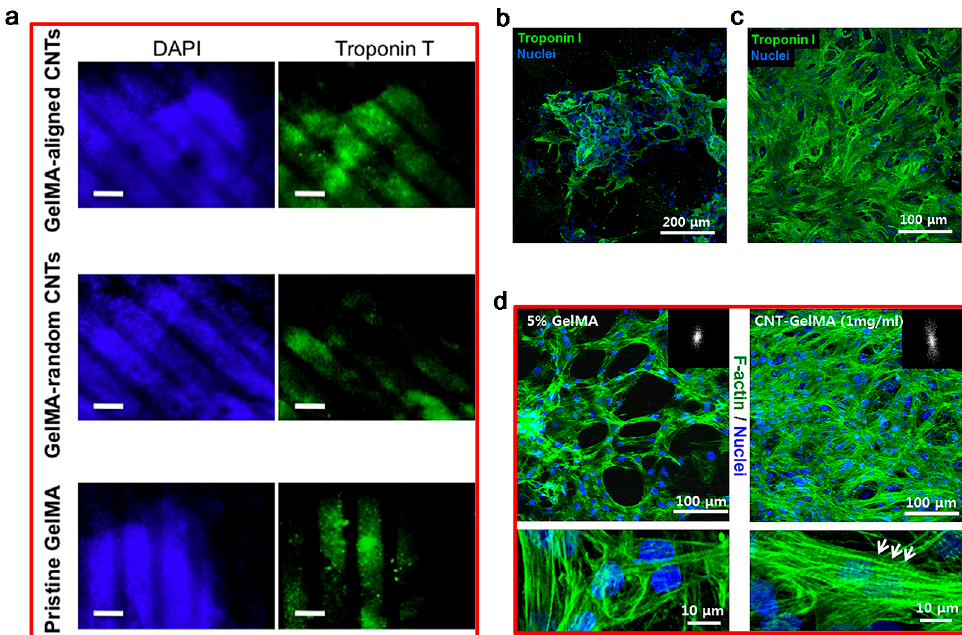
Figure 15. ( a ) Cardiac di ff erentiation analysis by applying DAPI (blue) and Troponin I (green) staining on pure GelMA and CNT–GelMA with embryoid bodies, by Ahadian et al. Low cardiac di ff erentiation is indicated by low expression of Troponin T [185]. (Right) Cardiac cell phenotype examination on the hydrogels by Shin et al. showed more aggregated Troponin I presence on ( b ) GelMA substrates than on ( c ) CNT–GelMA substrates. ( d ) Confocal images of GelMA and 1 mg / mL CNT–GelMA with cardiomyocytes cultured for five days [181]. Reproduced with permission from Ahadian et al., Acta Biomaterialia , published by Elsevier, 2016; and Shin et al., ACS Nano , published by American Chemical Society,